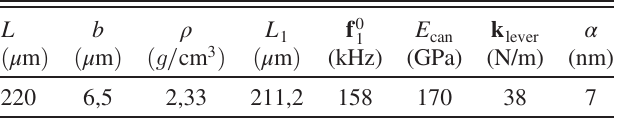
) lever of the lever